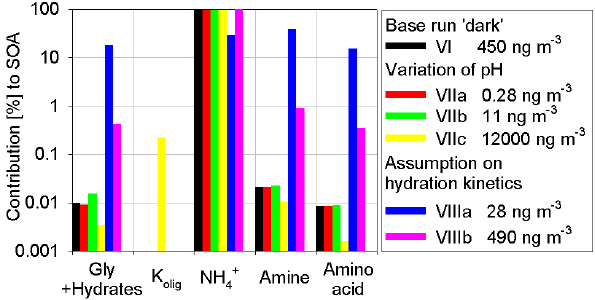
Fig. 7. Percent contributions [%] to predicted SOA masses by in- dividual processes in absence photochemical activity (night time). The numbers in the legend refer to the model runs as specified in Table 7; the reaction numbers on the x-axis refer to the reactions in Table 2. The masses [ngm − 3 ] denote the absolute predicted SOA masses for the respective runs as shown in Fig. 6.